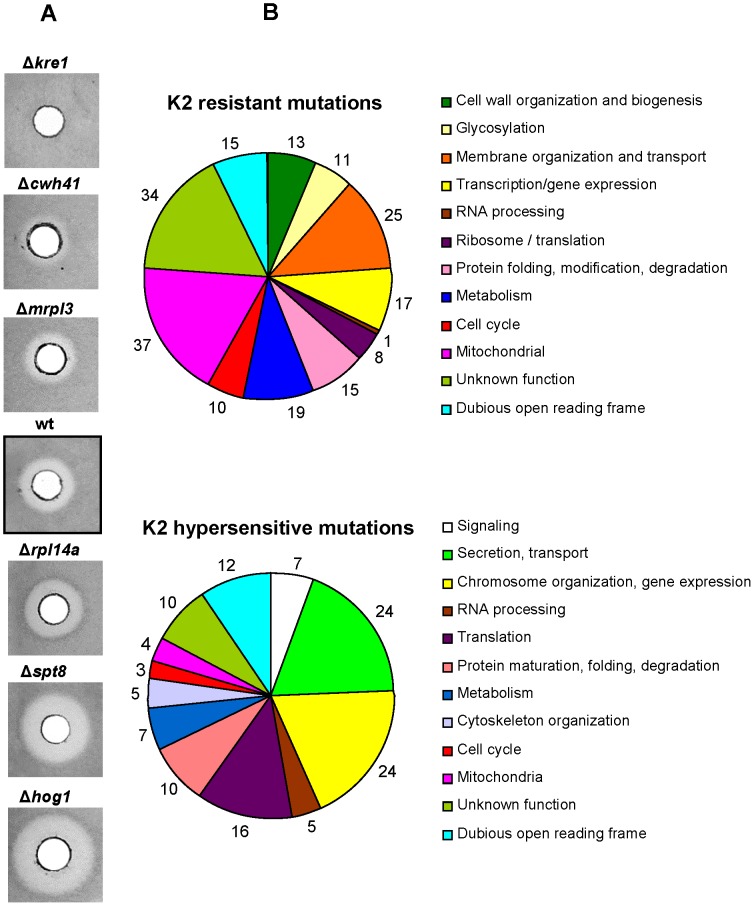
Distribution of cellular processes and cellular components involved in K2 resistance and hypersensitivity.A. Agar diffusion assays. Representative examples of “halo” observed for strains with different degree of sensitivity/resistance towards K2 toxin (see Figure 1B, screen 5, for details). An isogenic control (wt, strain BY4741) is provided in the center. Strains Δkre1, Δchw41, and Δmrpl3 are resistant (show a smaller “halo” than wild-type or no “halo”). Strains Δrpl14a, Δspt8, and Δhog1 are hypersensitive (show a larger “halo” than wild-type). B. Distribution of cellular pathways and cellular components, according to Gene Ontology, associated with the 205 genes associated with K2 resistance and 127 with K2 hypersensitivity. The number of genes identified in each class is indicated.